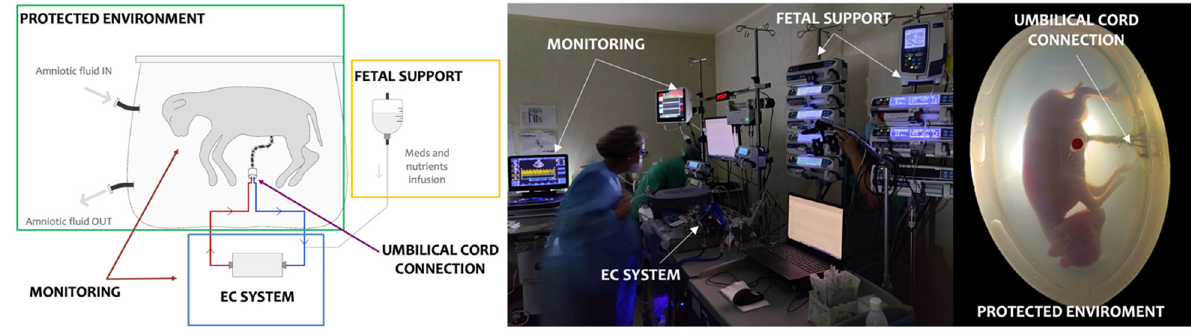
Figure 1. Main components of the artificial placental system. EC: extracorporeal circuit.